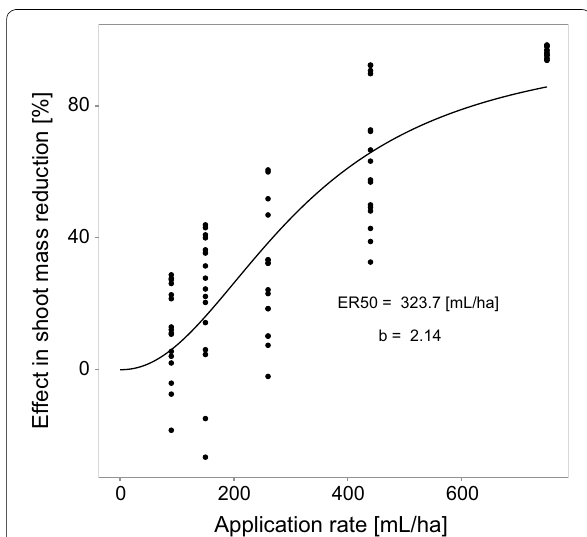
Fig. 3 Effects on the fresh weight (% reduction of fresh weight) of B. erectus in the monoculture treatment 4 weeks after application, when sprayed with different application rates of the broad spectrum herbicide RoundUp ® . Points show the empirically measured data and the line the estimated dose–response curve based on the dose-response function (Eq. 3), with the predictors for the ER50